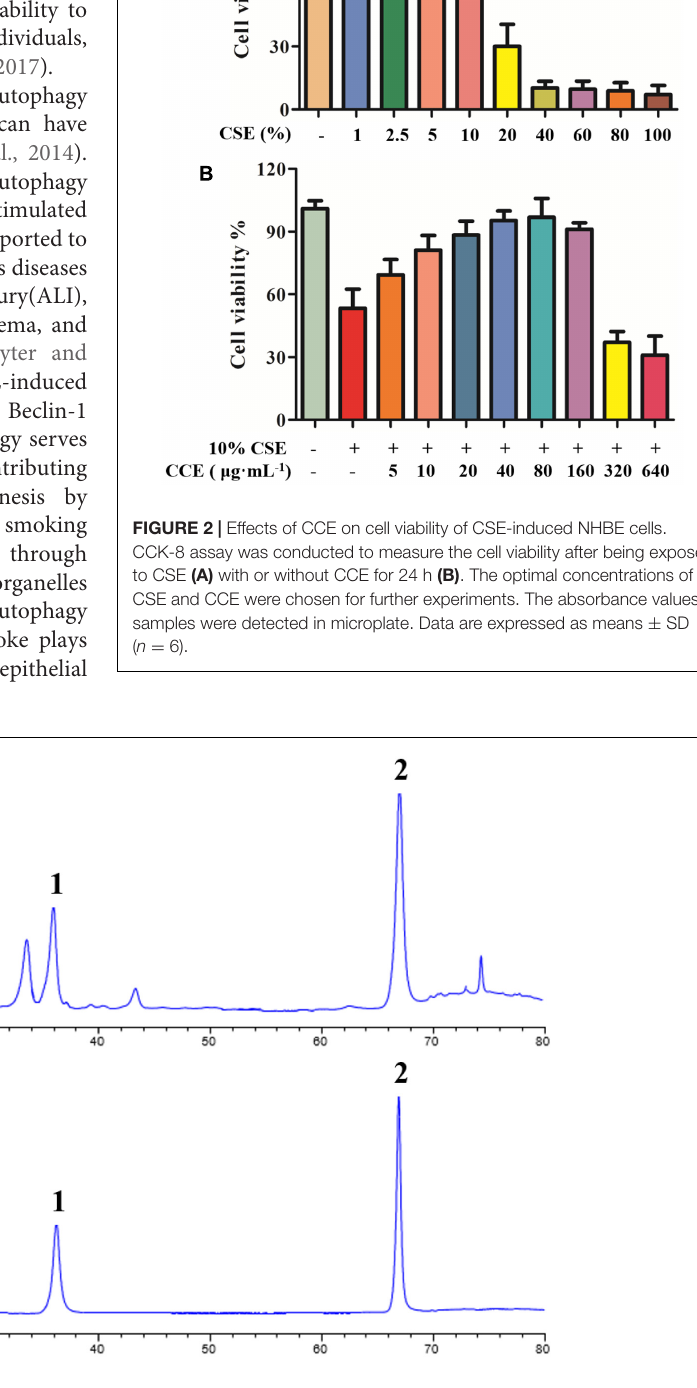
Frontiers in Pharmacology |